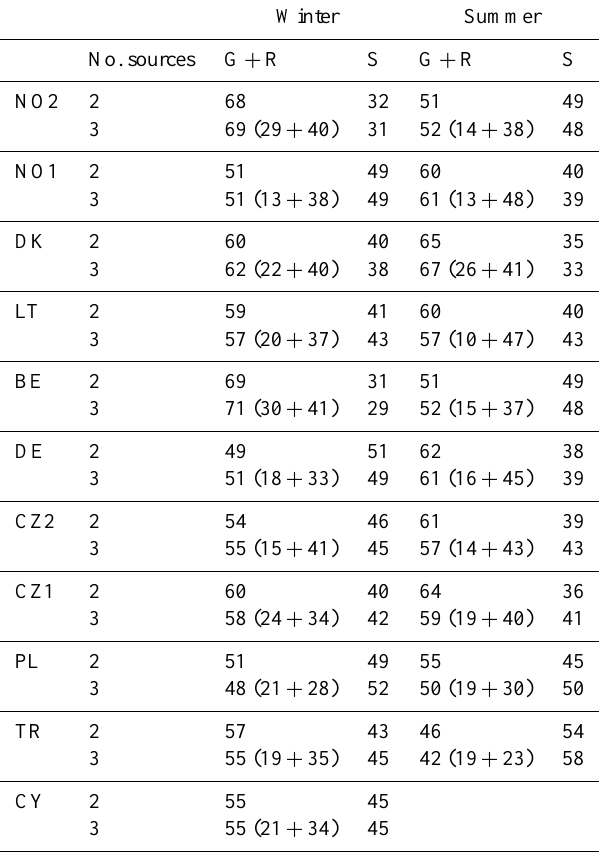
Table A1. Percentage of the total variance explained by the GCM– Table A2. Average RMSE from the comparison of the reconstructed RCM simulations (G+R) and one SDMs (S) considering two and and original values and the comparison with other combinations of three sources of variance. The contribution of the GCMs and RCMs is two shown in brackets Winter